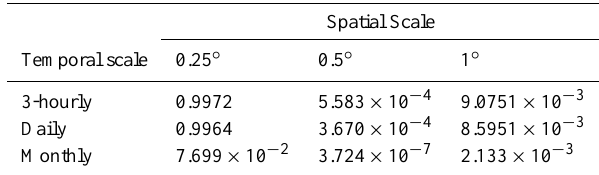
Table 2. Nonparametric t -test p values on